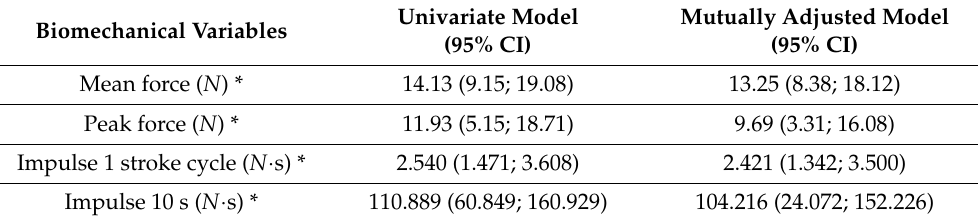
Table 3. Explanatory